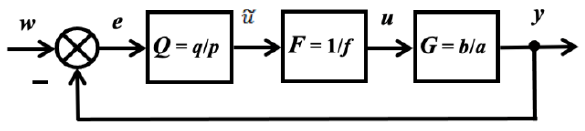
Figure 3. The general scheme of the self-tuning controller.